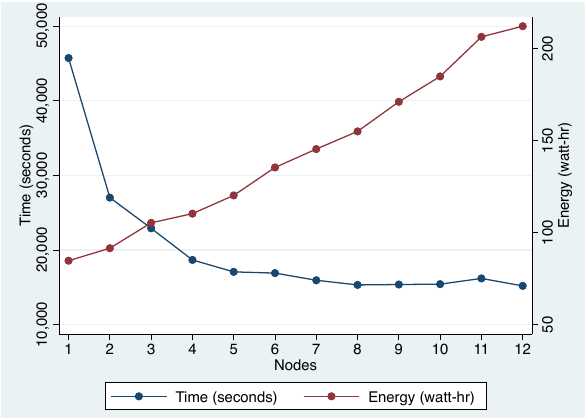
Figure 11. Execution time vs. energy consumption of a Montage 1.5 degree workflow on varying size of